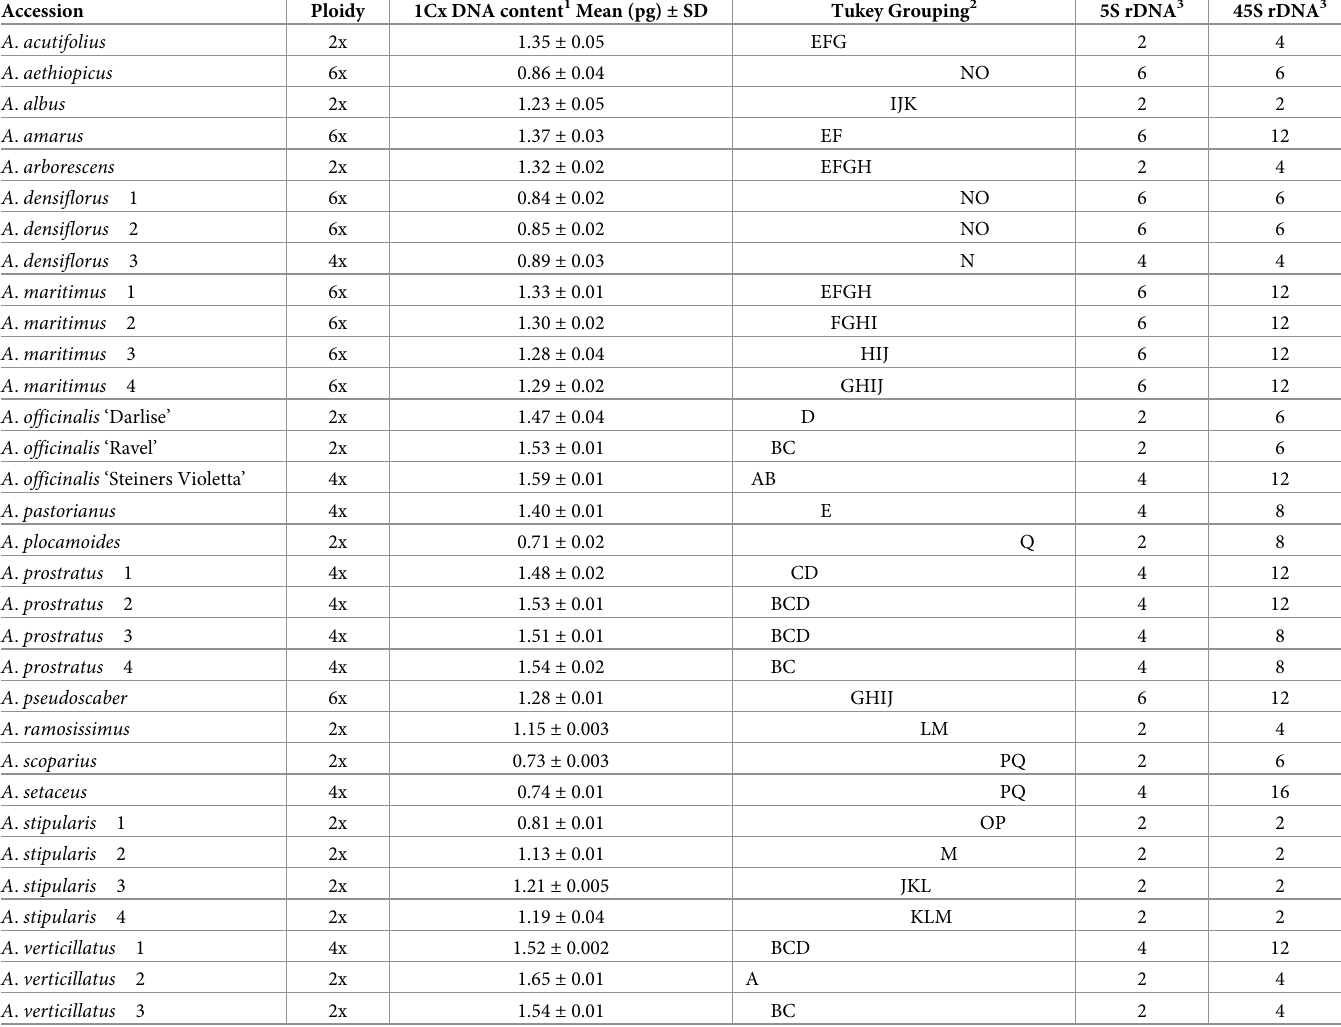
Table 3. Asparagus accessions with their calculated 1Cx DNA content estimated with flow cytometry using S . lycopersicon as internal standard and their number of 5S and 45S rDNA loci.